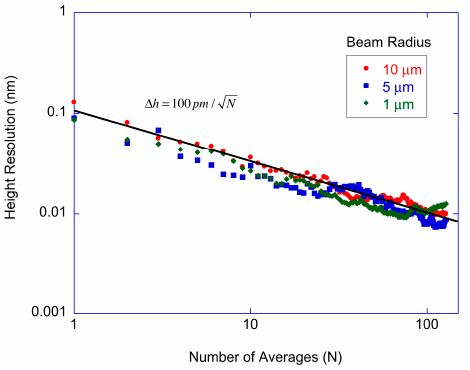
Figure 4. Single-track surface height resolution for repeated scans at the same radius. The data are for beam radii of 1, 5 and 10 μ m. The height resolution for each pixel after 100 averages is 10 pm.